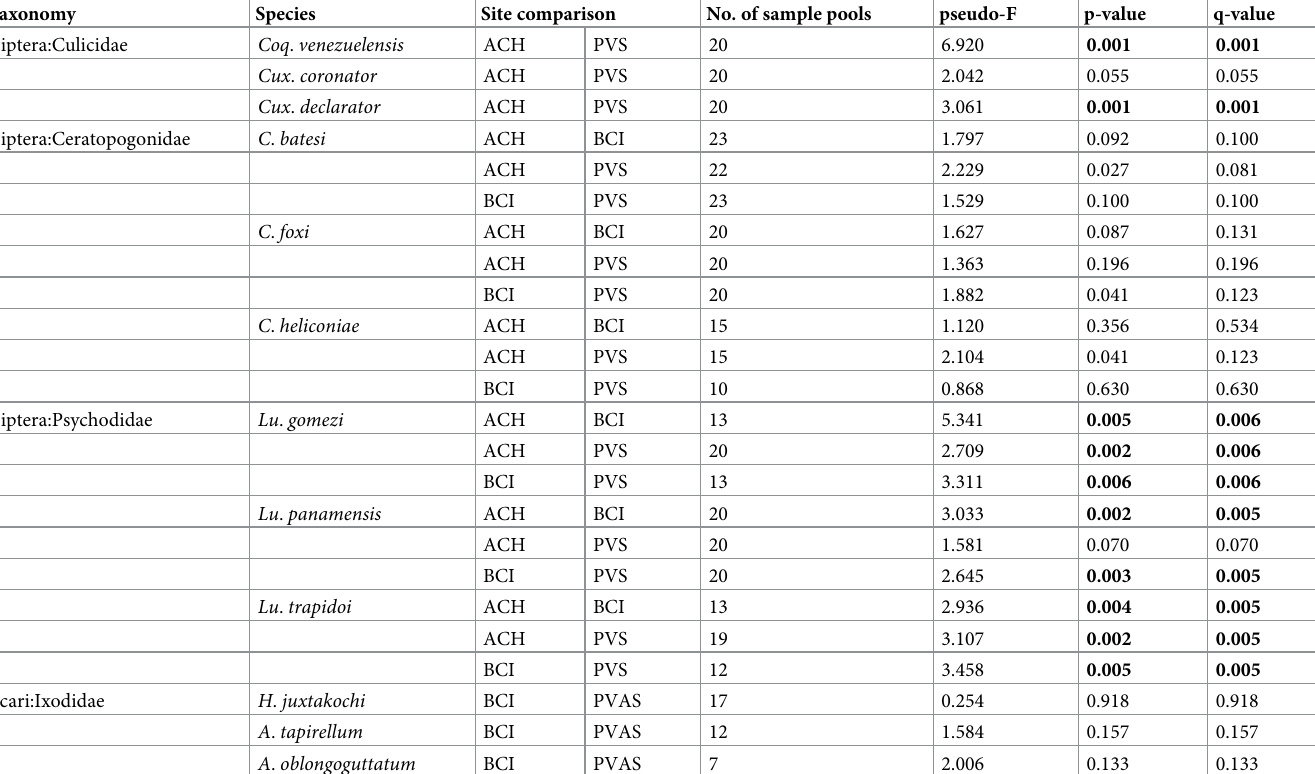
Table 3. Results of PERMANOVA test for the comparison of bacterial communities in pools of twelve different blood-feeding arthropod species among sampling areas based on unweighted UNIFRAC distances and 999 permutations. Significant results are highlighted in bold.